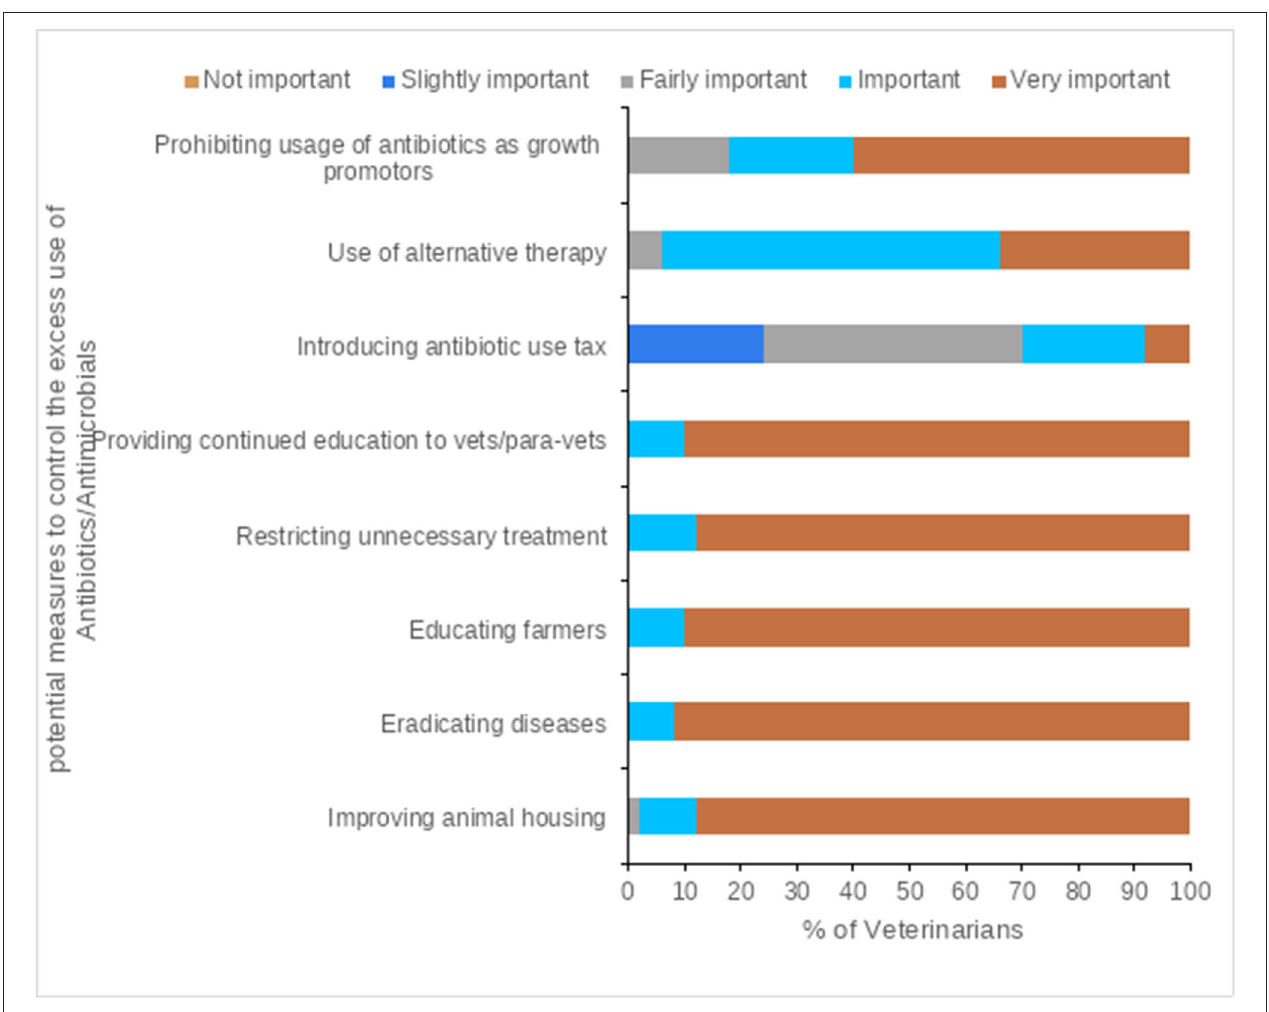
FIGURE 6 | Veterinarians’ attitudes to the potential measures to control the excess use of